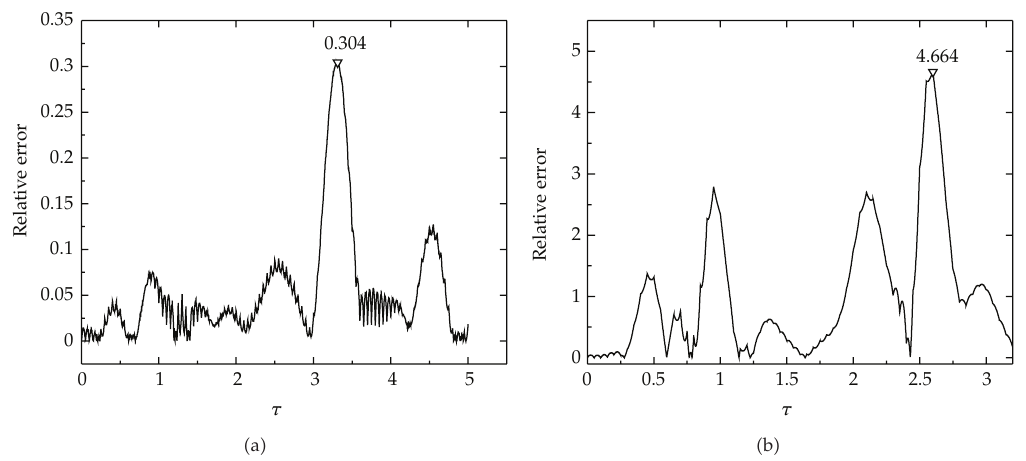
Figure 9: Relative error between 4th-order HAM solution and the corresponding numerical integration for displacement x (cid:3) τ (cid:4) ; (cid:3) a (cid:4) and (cid:3) b (cid:4) parts of this figure match with those in Figure 8.